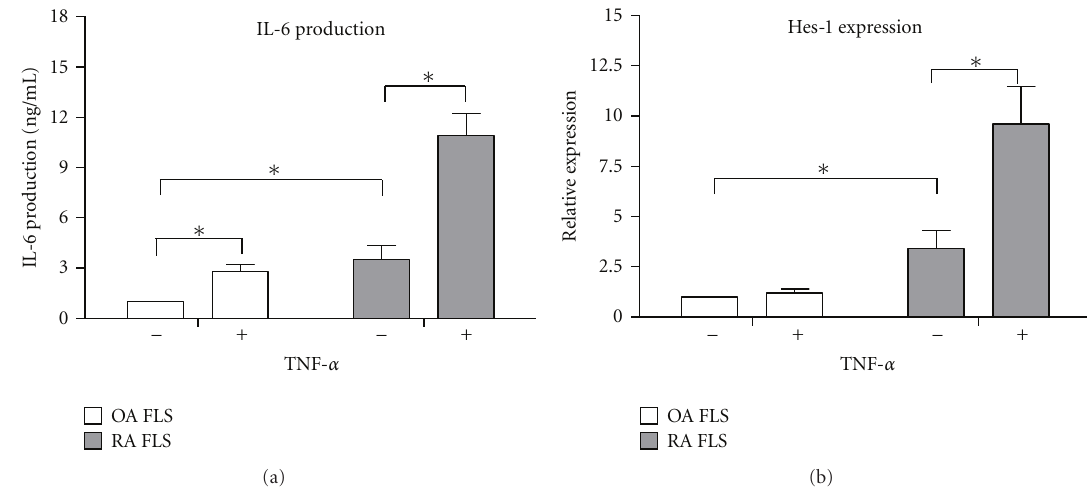
Figure 3: E ff ect of TNF- α stimulation on IL-6 and Hes-1 production in OA FLSs. (a) OA and RA FLSs were incubated with TNF- α (10ng/mL) for 24h, and then the supernatants were collected and analyzed for the IL-6 production by ELISA; (b) OA and RA FLSs were incubated with TNF- α (10ng/mL) for 24h, and then the cells were collected and analyzed for the Hes-1 mRNA expression by PCR. Each column is the mean ± SD. ∗ P < 0 .